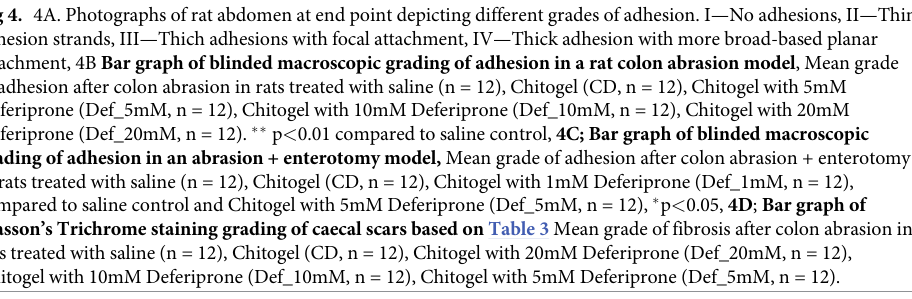
Fig 4. 4A. Photographs of rat abdomen at end point depicting different grades of adhesion. I—No adhesions, II—Thin adhesion strands, III—Thich adhesions with focal attachment, IV—Thick adhesion with more broad-based planar attachment, 4B Bar graph of blinded macroscopic grading of adhesion in a rat colon abrasion model , Mean grade of adhesion after colon abrasion in rats treated with saline (n = 12), Chitogel (CD, n = 12), Chitogel with 5mM Deferiprone (Def_5mM, n = 12), Chitogel with 10mM Deferiprone (Def_10mM, n = 12), Chitogel with 20mM Deferiprone (Def_20mM, n = 12). �� p < 0.01 compared to saline control, 4C; Bar graph of blinded macroscopic grading of adhesion in an abrasion + enterotomy model, Mean grade of adhesion after colon abrasion + enterotomy in rats treated with saline (n = 12), Chitogel (CD, n = 12), Chitogel with 1mM Deferiprone (Def_1mM, n = 12), compared to saline control and Chitogel with 5mM Deferiprone (Def_5mM, n = 12), � p < 0.05, 4D ; Bar graph of Masson’s Trichrome staining grading of caecal scars based on Table 3 Mean grade of fibrosis after colon abrasion in rats treated with saline (n = 12), Chitogel (CD, n = 12), Chitogel with 20mM Deferiprone (Def_20mM, n = 12), Chitogel with 10mM Deferiprone (Def_10mM, n = 12), Chitogel with 5mM Deferiprone (Def_5mM, n = 12). https://doi.org/10.1371/journal.pone.0244503.g004 1.1.4. Colon abrasion with enterotomy model. Adhesions seen in this group of rats as compared to the abrasion model were thicker and more abundant at the suture site. The mean adhesion score of the control rats treated with saline in the colon abrasion with enterotomy